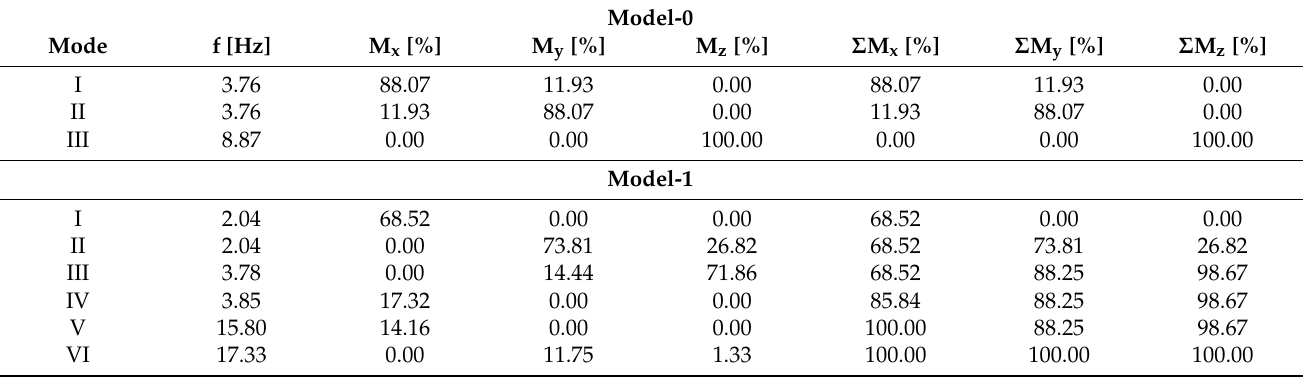
Table 2. Results of the preliminary FE models in terms of resonant frequency (f), percentage of par- ticipating mass in the x-direction M x (%), percentage of participating mass in the y-direction M y (%), percentage of participating mass around z-axis M z (%), and the sum of the participating mass in